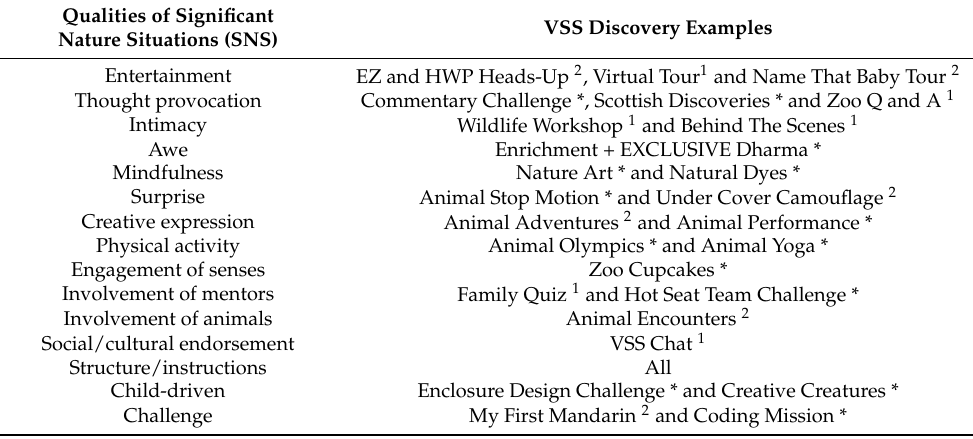
Table 1. Qualities of Significant Nature Situations (SNS) aligned with the Virtual Summer School activi- ties, 1 indicates live activities, 2 indicates recorded content and * indicates offline/prescribed activities. Qualities of Significant Nature Situations